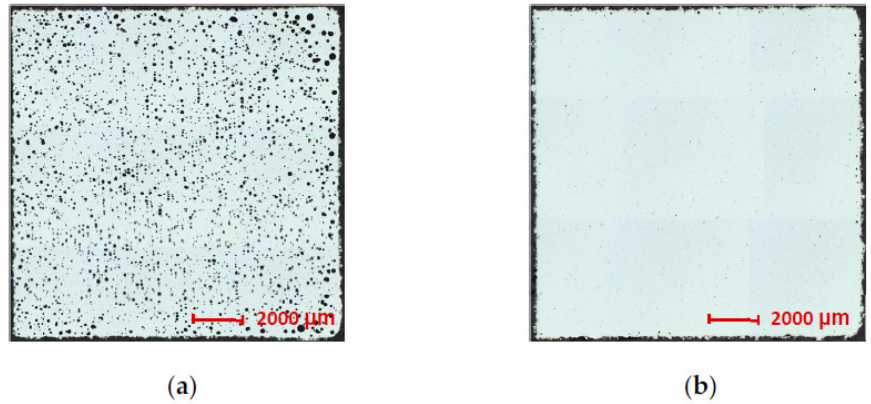
Figure 7. Cross-section images of the samples ( a ) 2-9 ( RD = 92.8%); ( b ) 3-19 ( RD = 99.4%).